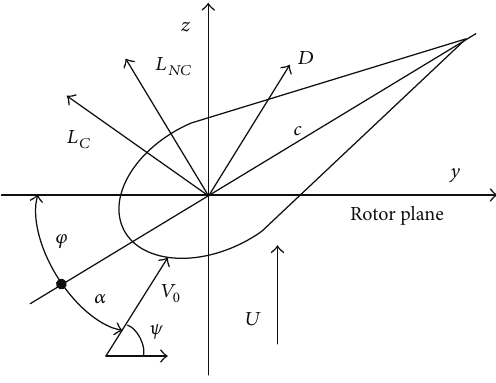
Figure 1: Coordinate system and aerodynamic